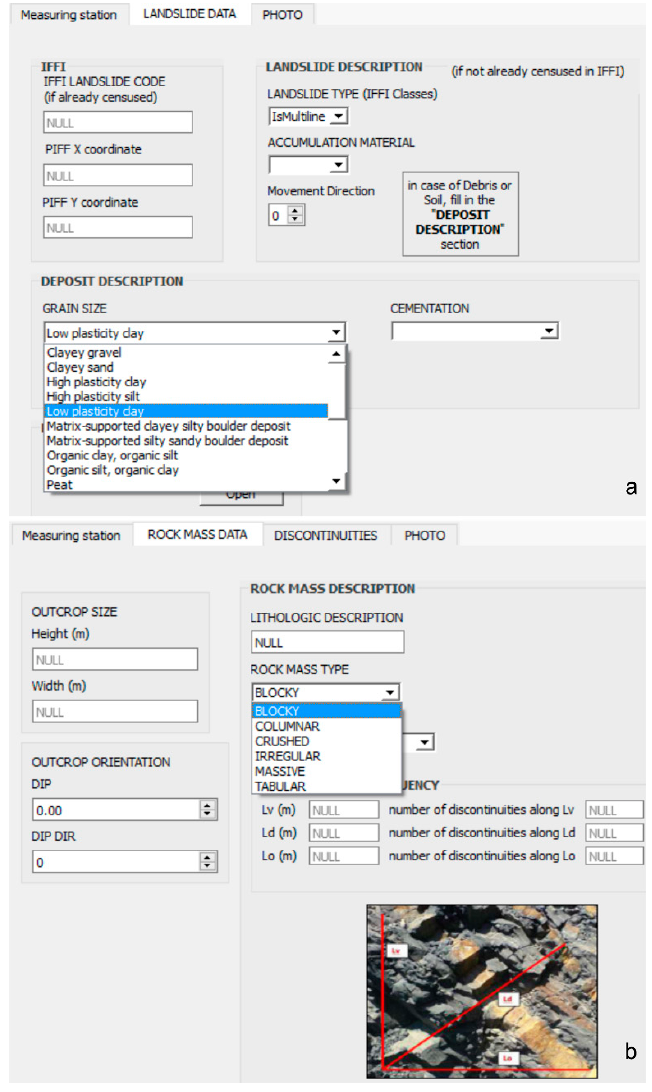
Figure 5. Input forms with combo boxes containing a drop-down list of the geotechnical data values required by the Parsifal method: ( a ) example of “Grain Size” attributes; ( b ) example of “Rock Mass Type” attributes.